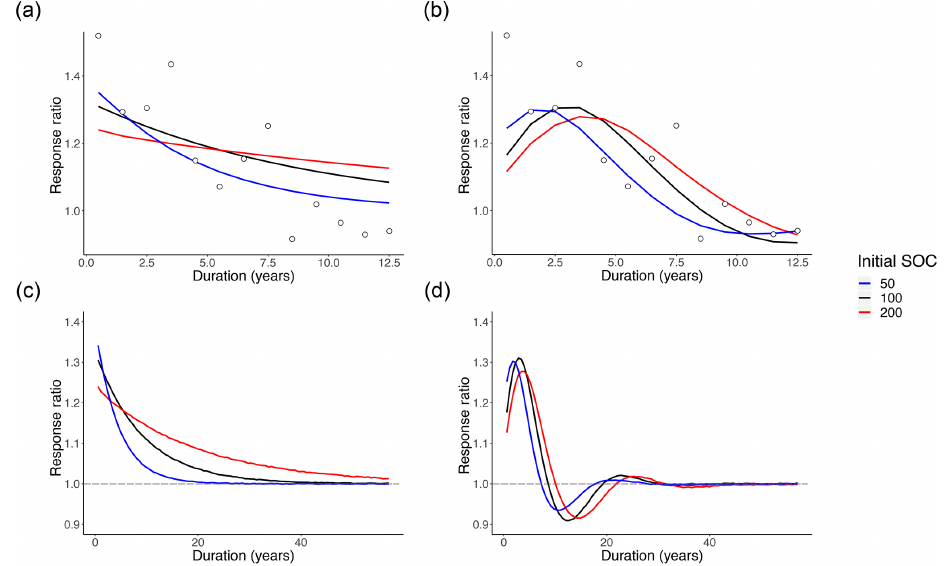
Figure 3. Intramodel comparisons of mean posterior predictive response ratio fits for AWB and CON across different MIC-to-SOC ratios. Open circles show the meta-analysis data points for reference. The blue, black, and red lines indicate model mean fits corresponding to different prewarming steady-state SOC values of 50, 100, and 200mgCg − 1 soil. The dashed gray line indicates the steady-state expectation at the response ratio of 1.0. Mean fits are plotted in order of (a) CON and (b) AWB over the time span of the data and (c) CON and (d) AWB over 57